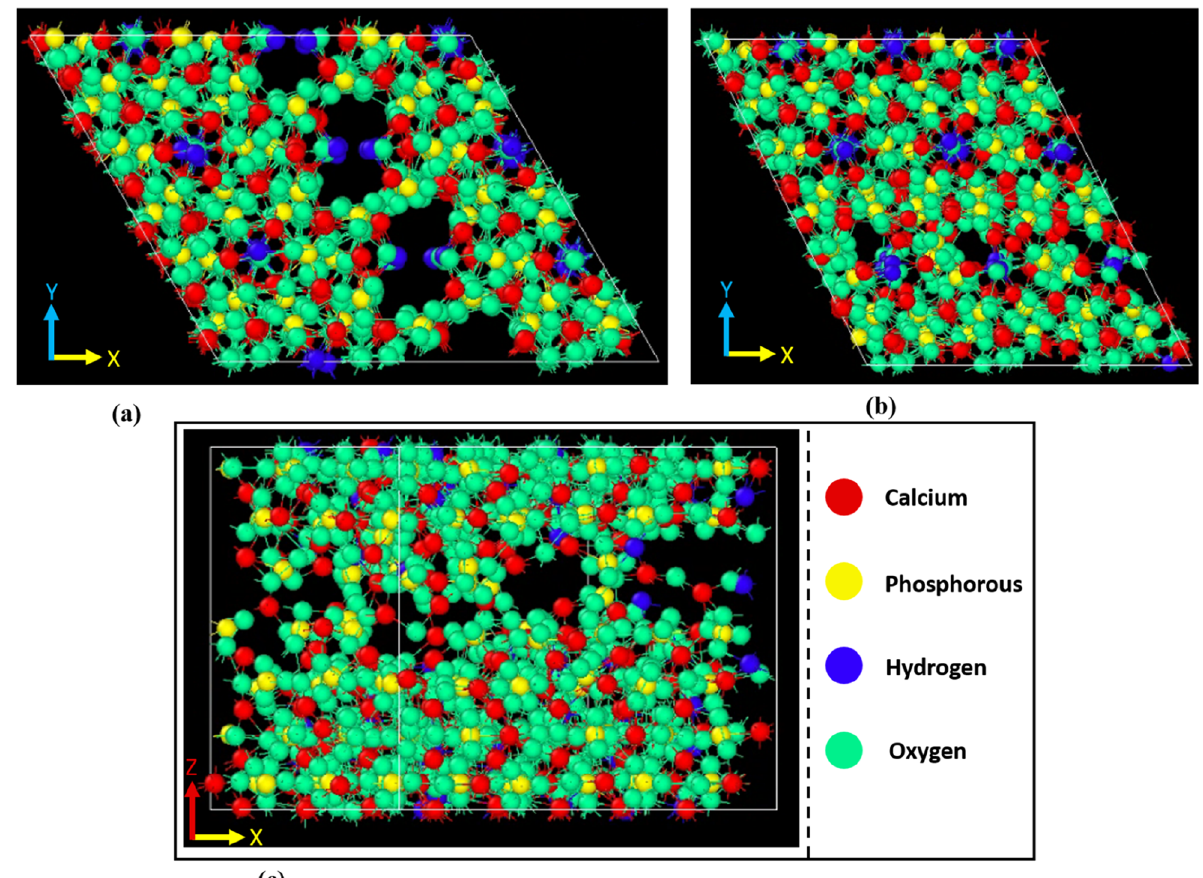
Figure 9. MD simulation acquired snapshot of undoped HA (0FeHA) at T = 300 K at the vicinity of TS (highest point on the stress-strain curve), when load is applied along ( a ) X-axis, ( b ) Y-axis and ( c ) Z-axis. (Sample designation: xFeHA means x mol% Fe 2+ -doped